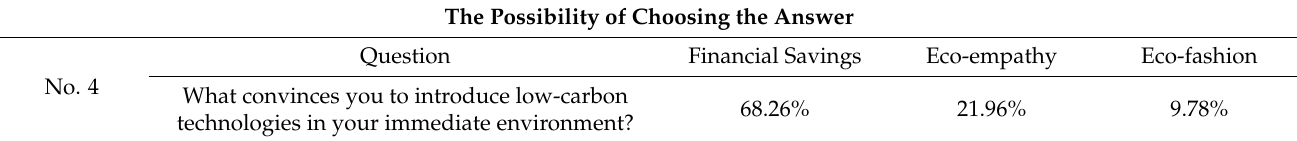
Table 4. Question no. 4, research